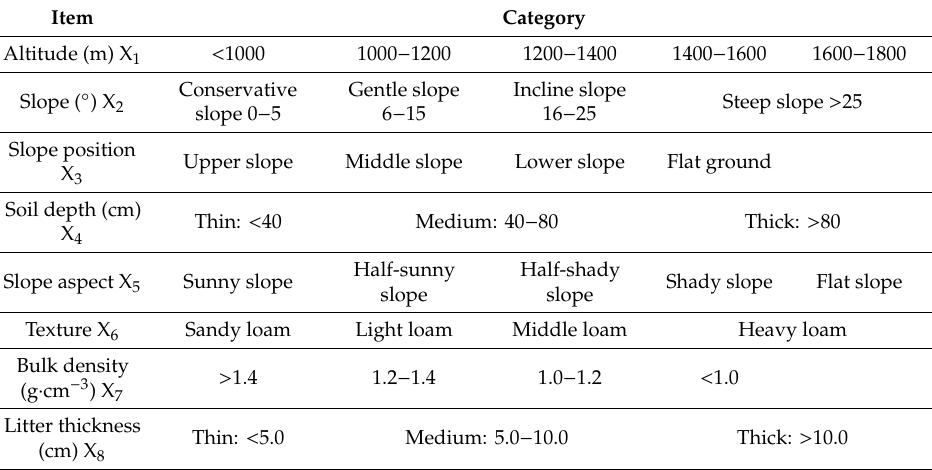
Table 1. Category classification of site factors.